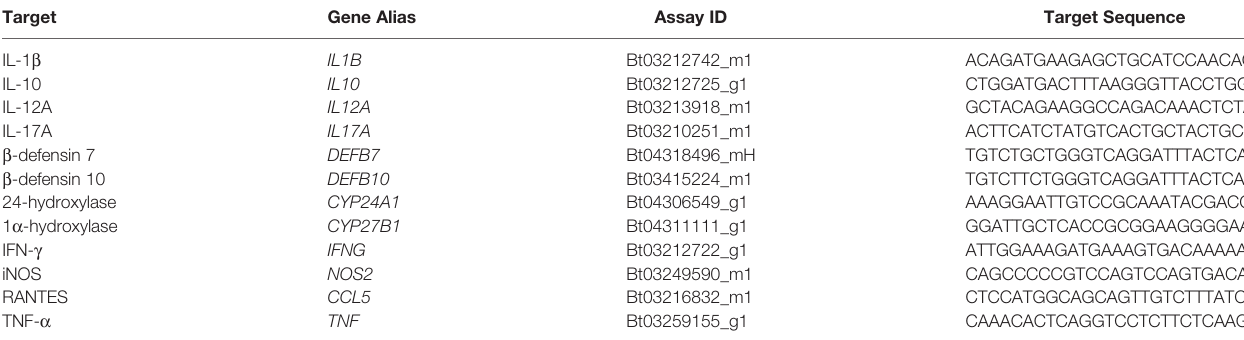
TABLE 1 | ThermoFisher Scienti fi c gene expression